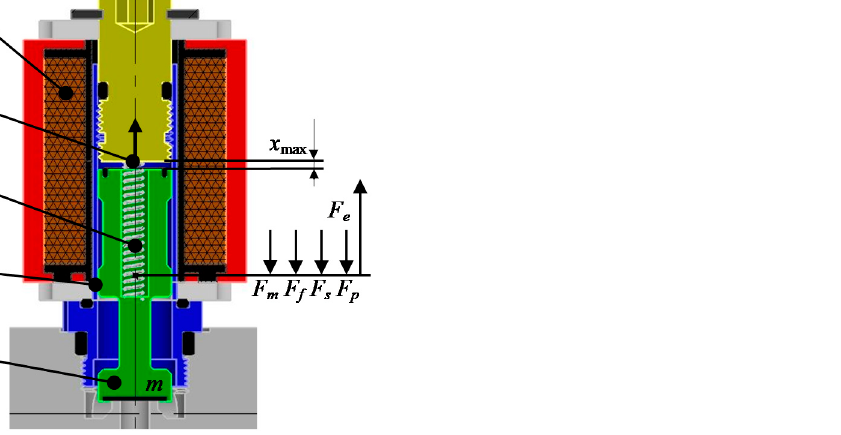
Figure 2. The scheme of the Valtek Rail Type-30 gas injector: F e —electromagnetic force; F f —frictional force; F s —spring force; F p —pressure force; F m —resistance force of mass inertia; x —plunger